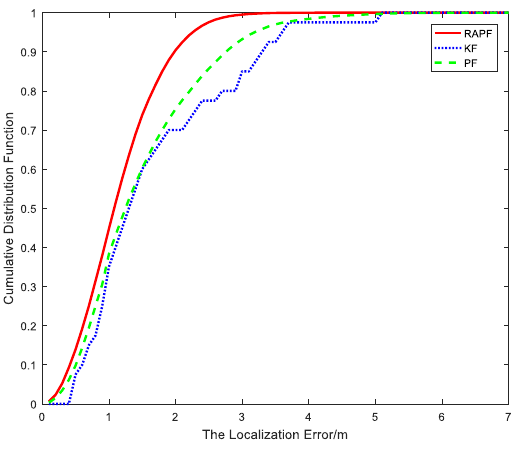
Figure 23. The CDF versus the localization error.